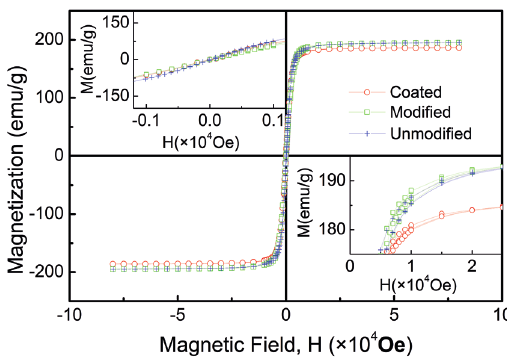
Figure 4: Room–temperature magnetic hysteresis loops of ferrosilicon particles water on the surface of the ferrosilicon particles occurred, with a weight loss corresponding to a wide adsorption peak which can be seen from DSC curve. TG reveals the course of the weight loss at 180 resulting from the oxidation of carbon. As all of the above-mentioned processes occur at ℃ the surface of ferrosilicon particles, the change in the DSC curve is attributed to the endothermic